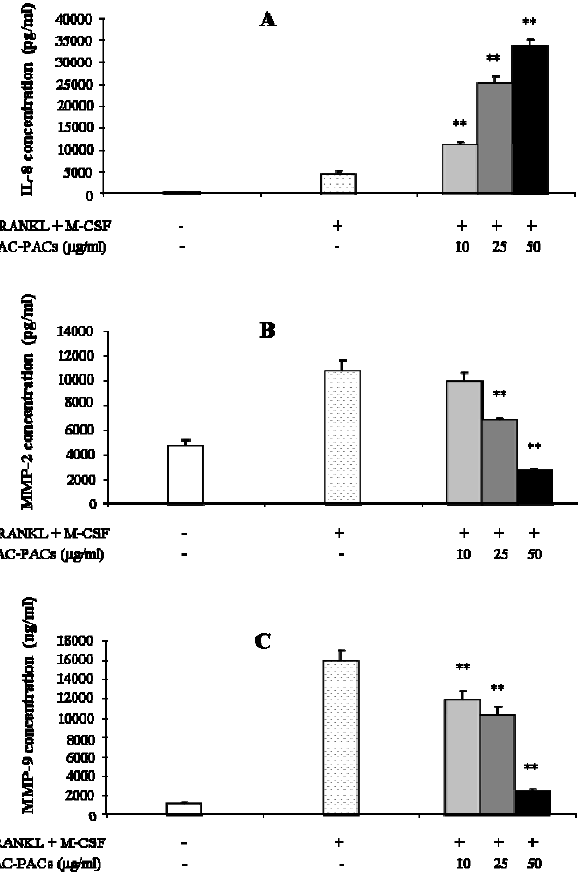
Figure 4. Effect of AC-PACs on secretion of IL-8 and MMPs by osteoclastic cells treated with AC-PACS. (A) IL-8 secretion. (B) MMP-2 secretion. (C) MMP-9 secretion. ** p <